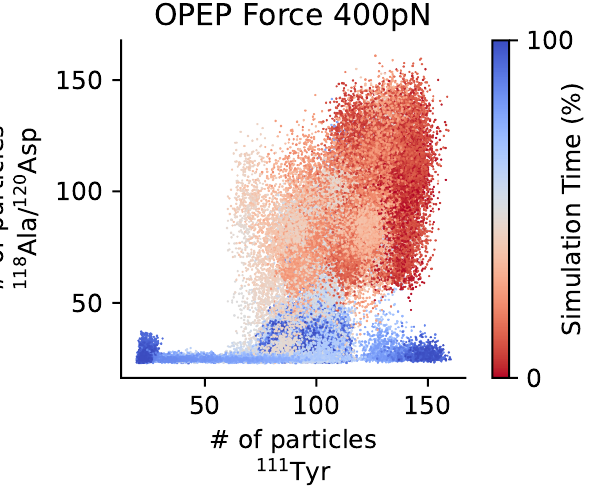
Figure 4. Exposure of the cleavage and the recognition sites of A2 domain under force. The CG trajectories of force unfolding (400 pN) are projected as a scatter plot on the 2D space of the coordi- nation number of 111 Tyr (cleavage site) and that of 118 Ala/ 120 Asp (recognition site). The sequential exposure of the recognition site before the cleavage site can be appreciated. Trajectories are colored according to progress from red (beginning) to blue